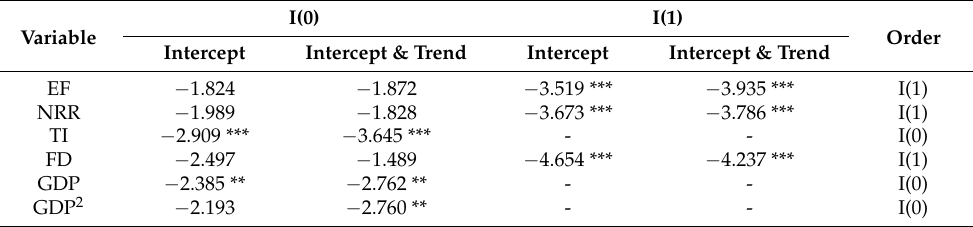
Table 3. CIPS panel unit root test result in BRI